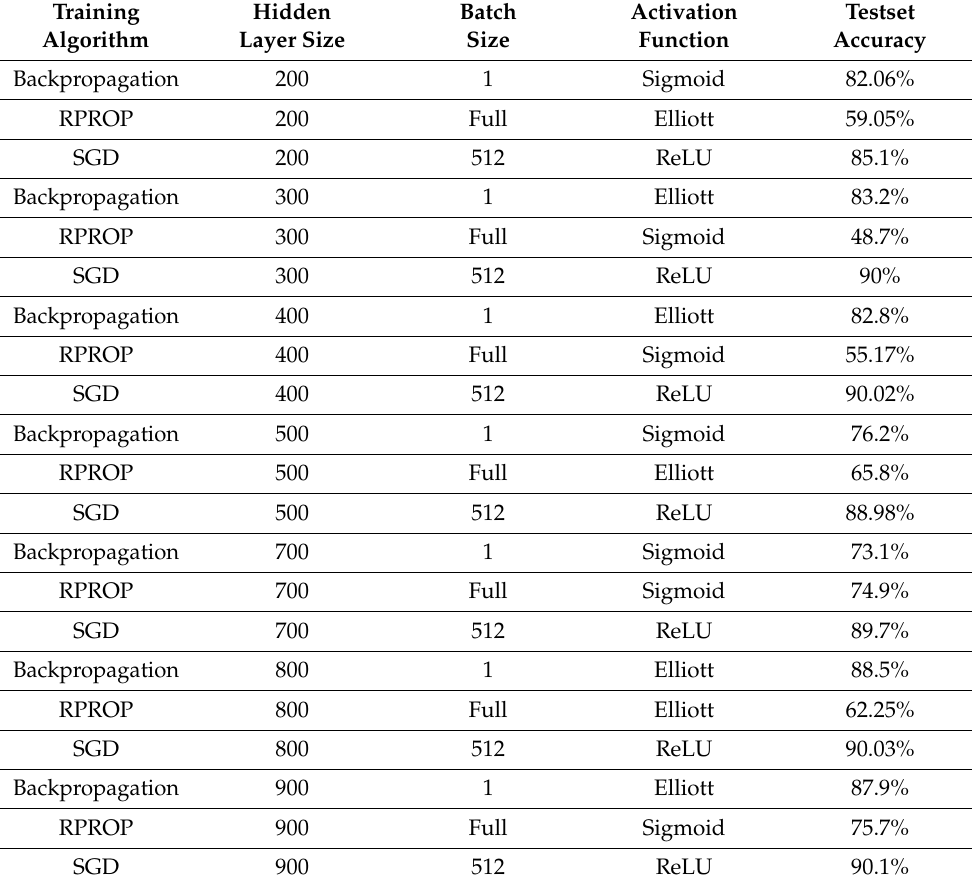
Table 1. Training with different hidden layer sizes and activation